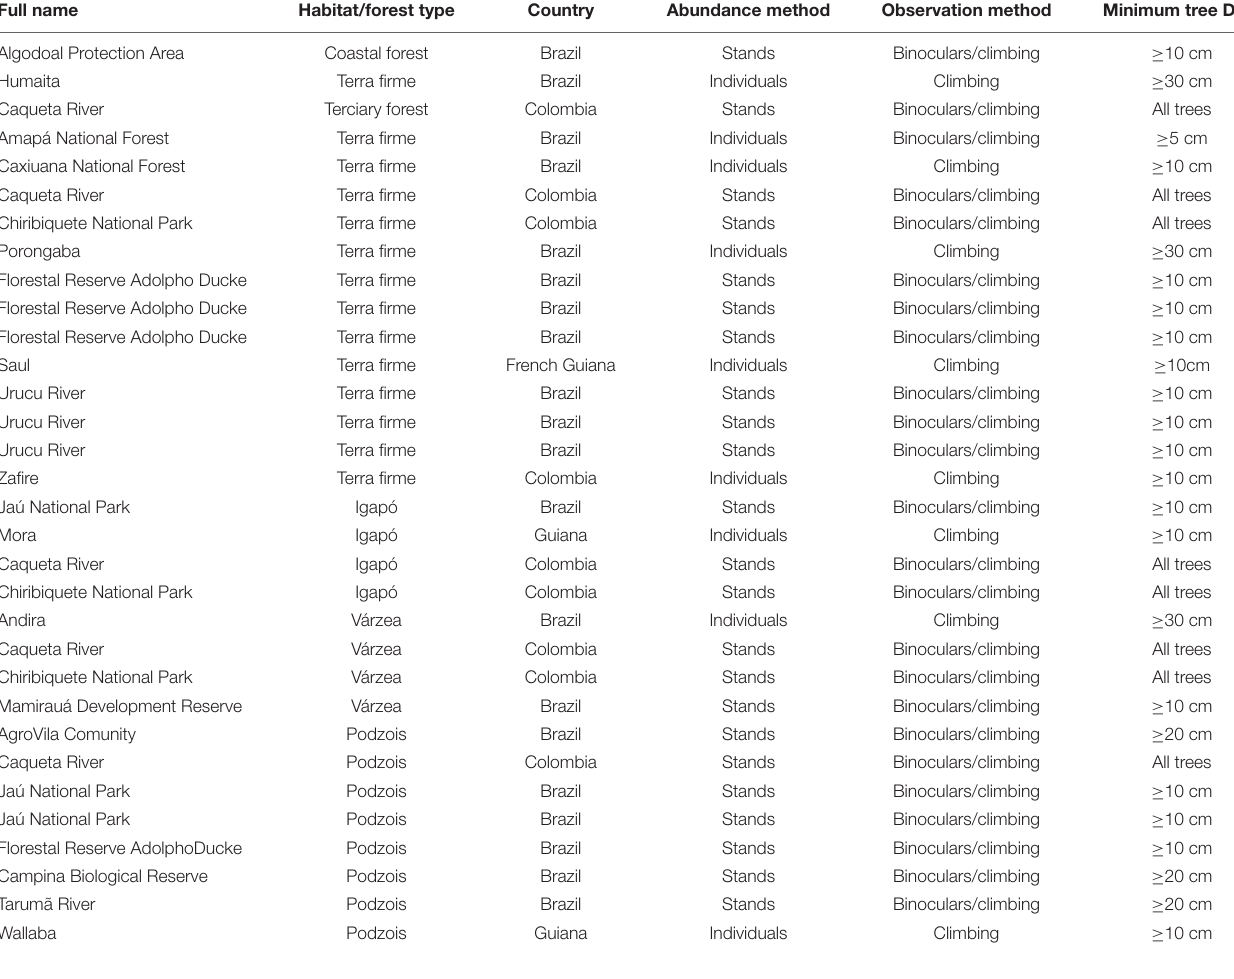
TABLE A1 | Detailed description of sampling methods for Amazon vascular epiphytes in 32 different